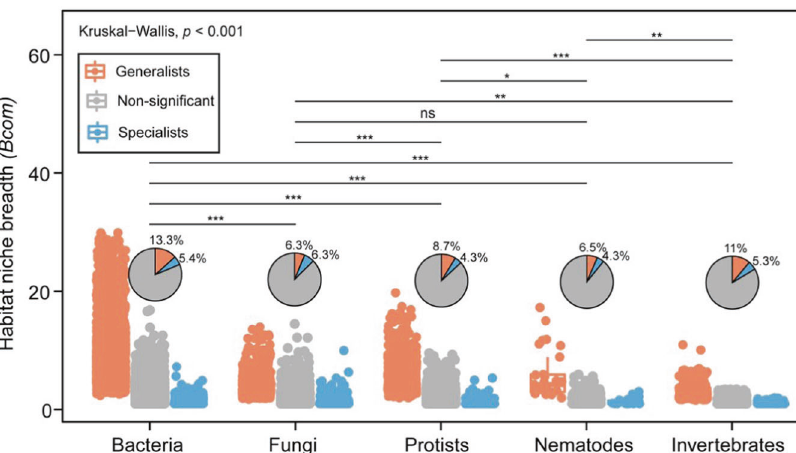
Fig. 5 Habitat niche breadths ( Bcom ) of the studied taxonomic groups and corresponding percentages of habit specialists and generalists. The boxplots and the pie charts illustrate, respectively, the niche breadth and the percentage contribution of the specialist and generalist taxa within each group. Statistical signi fi cance among all groups and between each group pair was tested by using, respectively, the Kruskal-Wallis rank sum and Wilcoxon tests. *, p < 0.05, **, p < 0.01, ***, p < 0.00, ns: not-signi fi